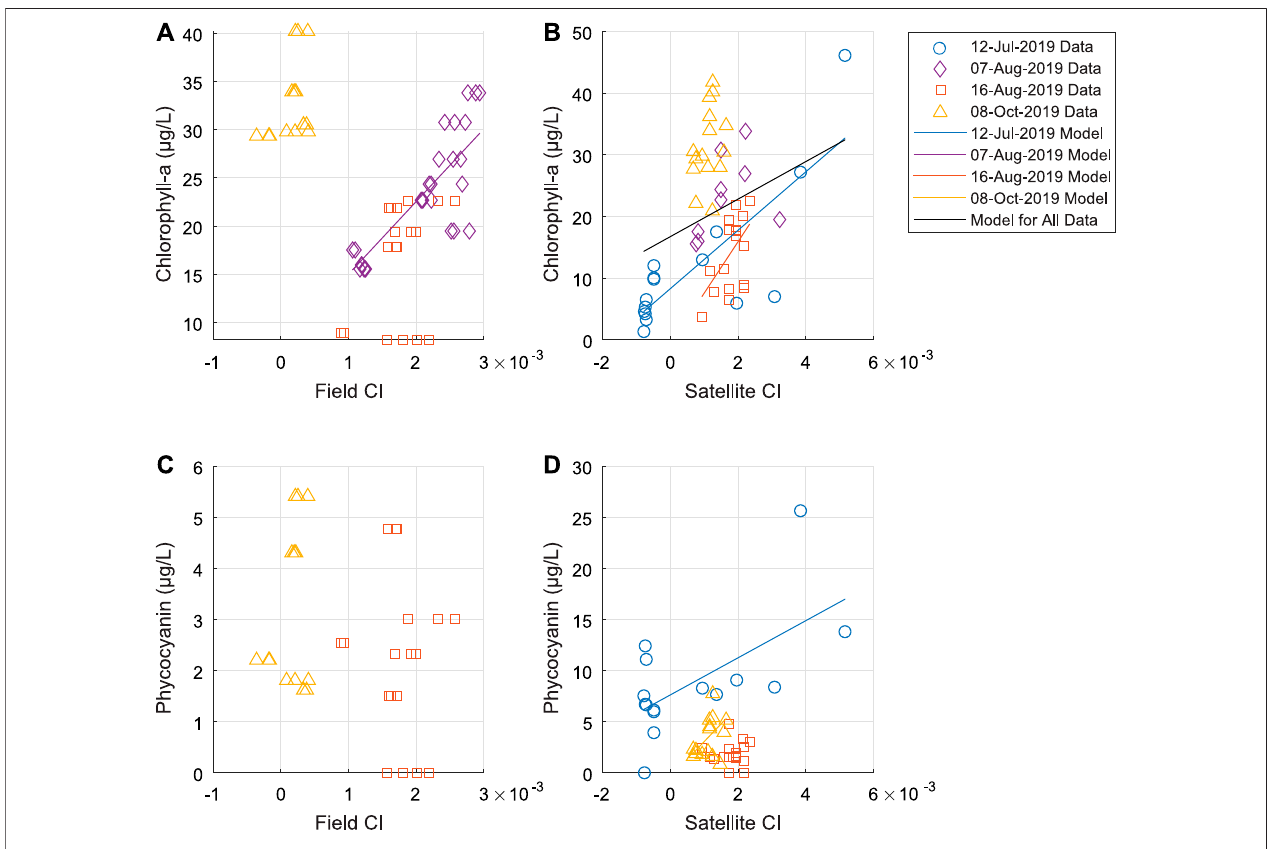
FIGURE5| Relationshipof (A) CIfrom fi eldspectroradiometerdatatochlorophyll- a concentration (B) CIfromsatellitedatatochlorophyll- a concentration (C,D) as (A,B) exceptfortophycocyaninconcentration.Notethedifferenceinaxesrangesbetweeneachplot.Linearmodelsareshownforthoserelationshipsthataresigni fi cant (corrected p -value < 0.05, where p -value is corrected using Benjamini and Hochberg False Discovery Rate procedure). Few ofthe modeled relationships are signi fi cant.